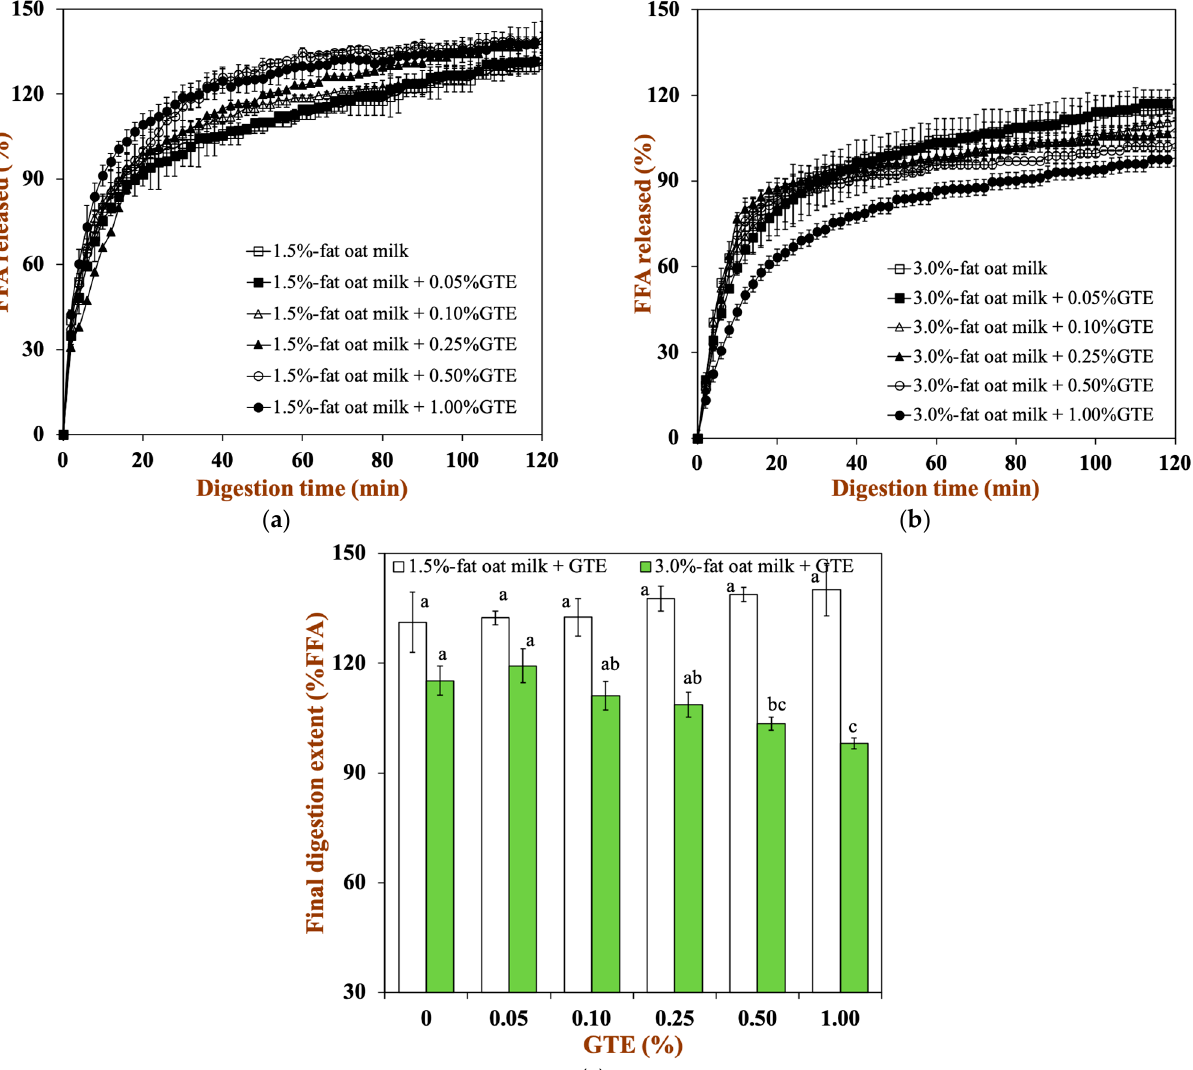
Figure 6. The total amount of FFA released from two oat milk tea model systems with various GTE concentrations: ( a ) 1.5% fat oat milk tea model system and ( b ) 3.0% fat oat milk tea model system. ( c ) Final extent of FFA release after exposure to 2 h of small intestine digestion. Samples with different lowercase letters indicate significant differences ( p < 0.05) when compared to various concentrations of green tea extract.